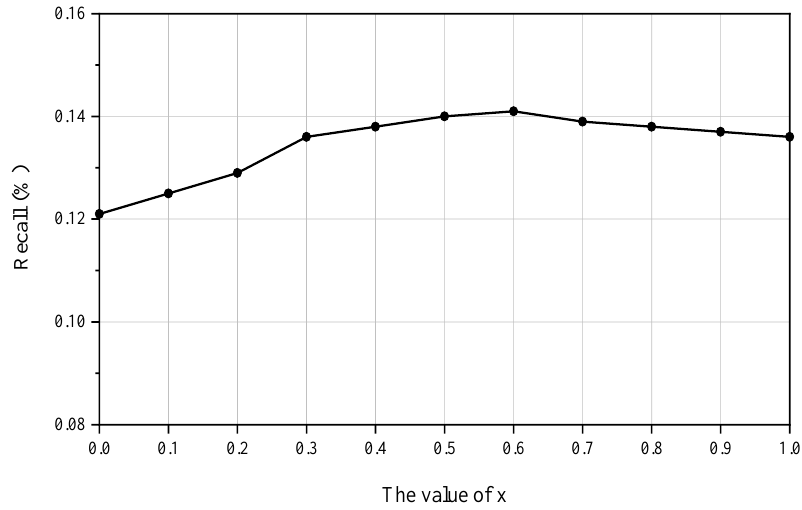
Figure 5. Precision under different values of x.